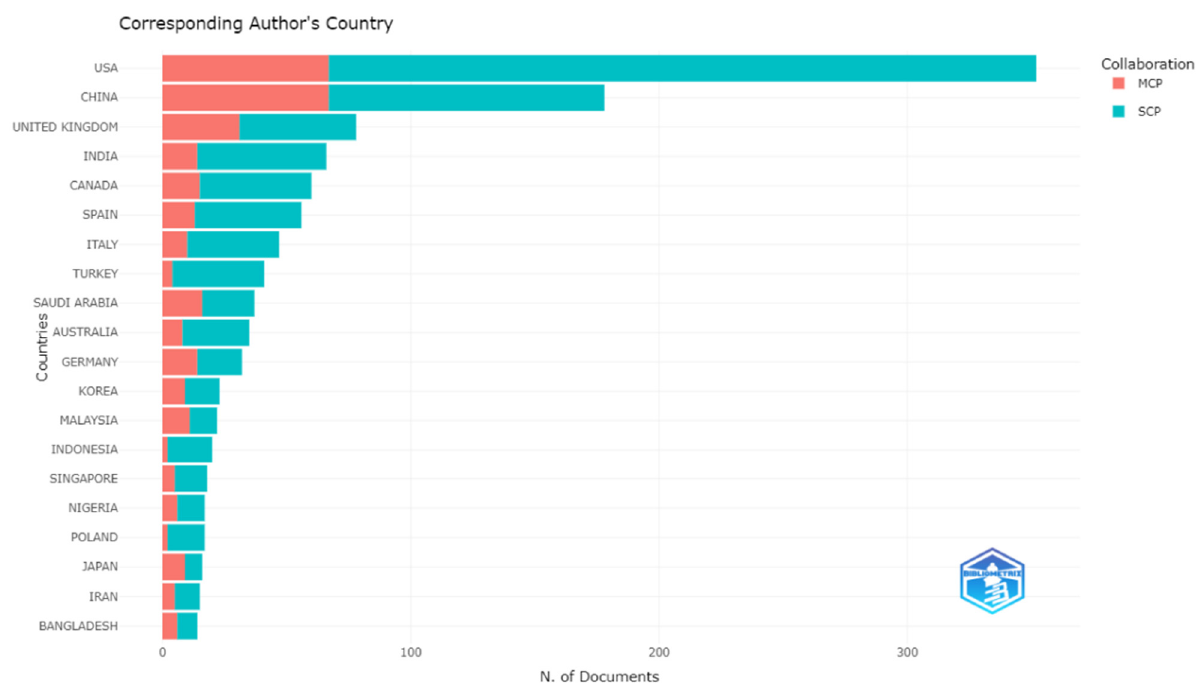
Figure 1. Top 20 most productive countries (this chart was generated by Biblioshiny). Table 6. Top 20 most productive